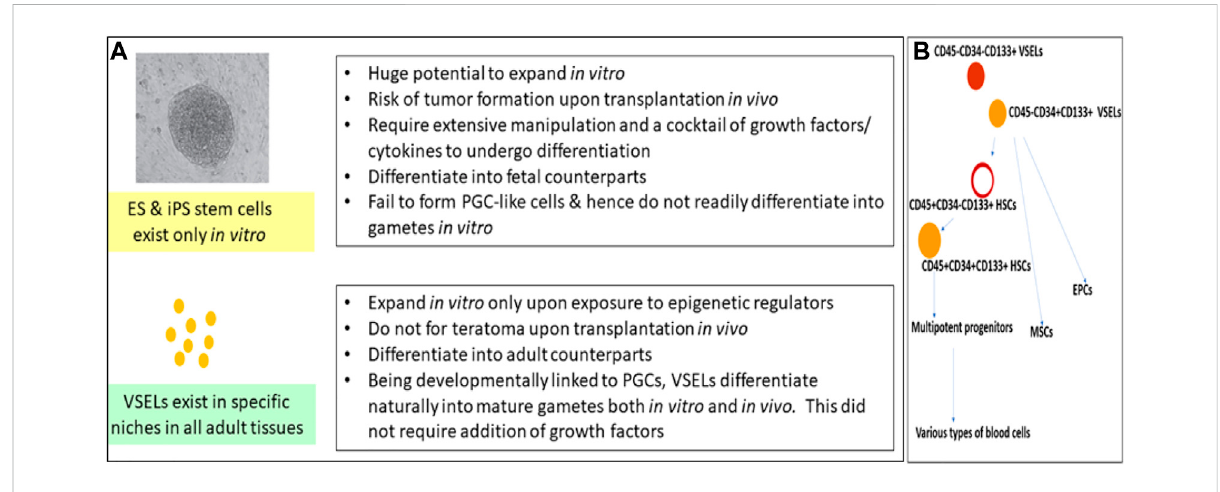
FIGURE 1 (A) compares VSELs with ES and iPS cells. Pluripotent VSELs exist in adult tissues; they regularly participate in adult tissue regeneration and remodeling,withnoriskofteratomaformation.Morefocusedresearcheffortsarerequiredtomakeuseoftheirregenerativepotential. (B) showsthat VSELs sit at the top of the hematopoietic system hierarchy, and that they give rise to HSCs, MSCs, and EPCs. VSELs, very small embryonic-like stem cells; ES cells, embryonic stem cells; iPS cells, inducedpluripotent stem cells; HSCs, hematopoieticstem cells; MSCs, mesenchymal stem cells; EPCs, endothelial progenitor